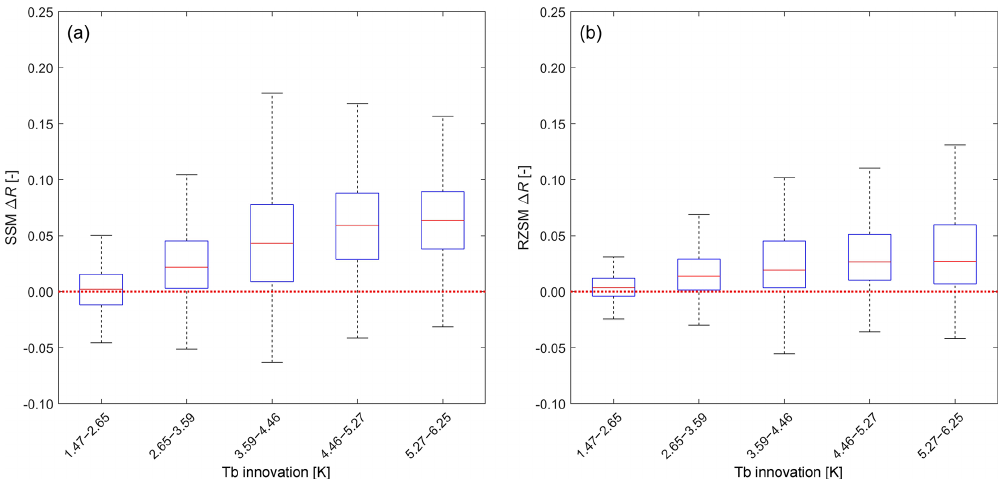
Figure 6. SMAP L4 DA skill improvement ( (cid:49)R = R L4 − R OL ) as a function of T b innovation for (a) SSM and (b) RZSM. Samples with T b innovation ranking above the 80th percentile are excluded from the